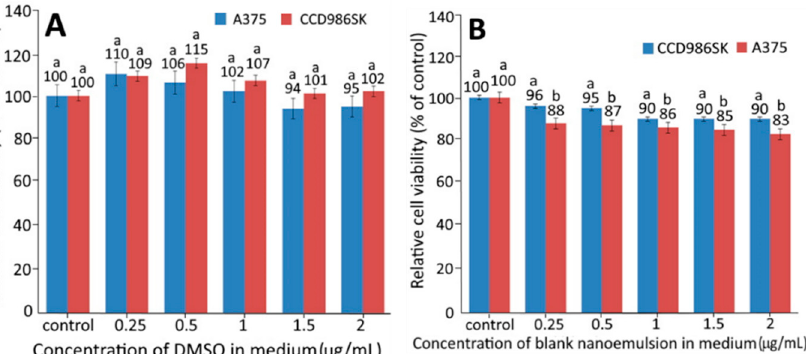
Figure 3. Effect of different concentrations of DMSO ( A ) and blank nanoemulsion ( B ) on growth of fibroblast cells CCD966SK and human melanoma cells A375 after 48 h incubation as measured by MTT assay. Data represent mean ± standard deviation ( n = 3) with different small letters (a,b) indicating significantly different values at p < 0.05.